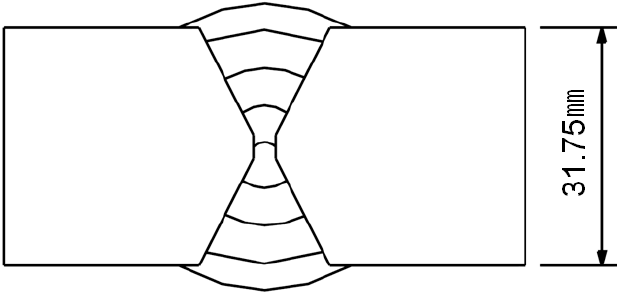
Figure 3. Geometry of X-groove weldment and welding deposition sequence.